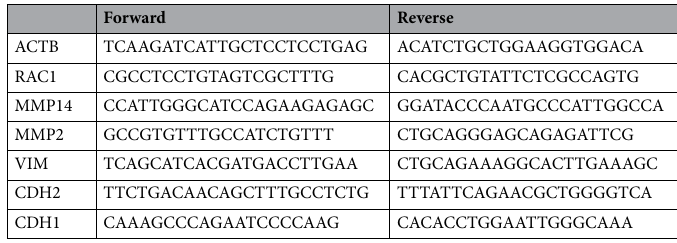
Table 2. Sybr Green PCR primers.